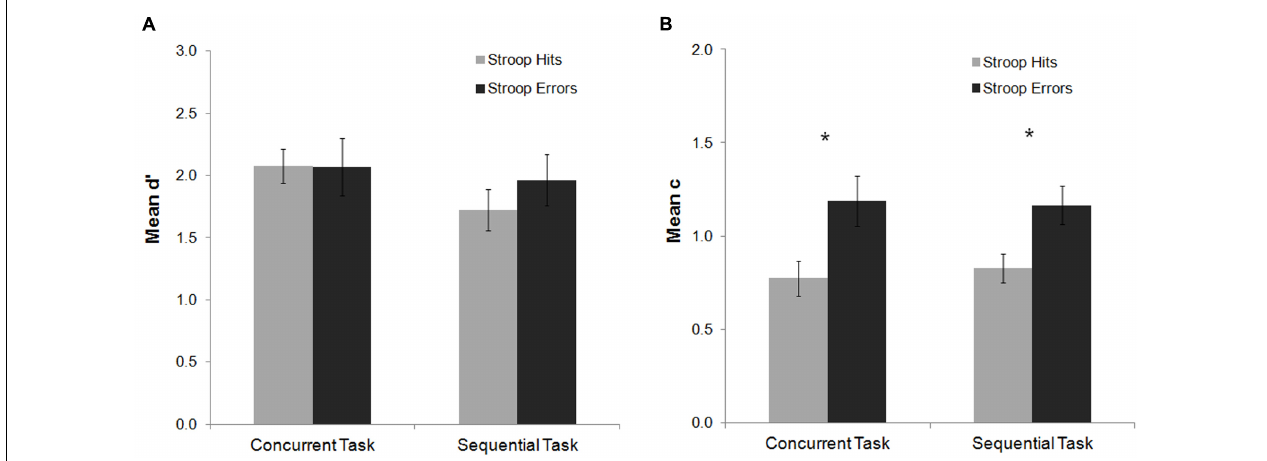
FIGURE 3 | Mean d (cid:48) and c indexes as a function of task and Stroop response accuracy in Experiment 1. No significant effects were observed on the analysis of the mean d (cid:48) index (A) . For the c index (B) response criterion to detect the Gabor was more conservative after an error on the Stroop task as compared to hit trials for both the concurrent and sequential tasks. Bars represent standard errors. Asterisks represent significant effects for the Fisher post hoc comparisons ( p < 0.05).